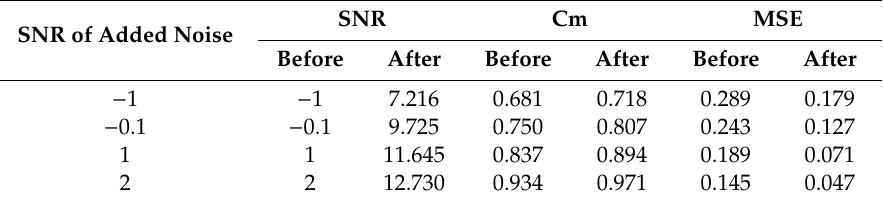
Figure 20. MSE values along with iterations. Table 2. The denoising indicators with different noise levels before and after denoising.